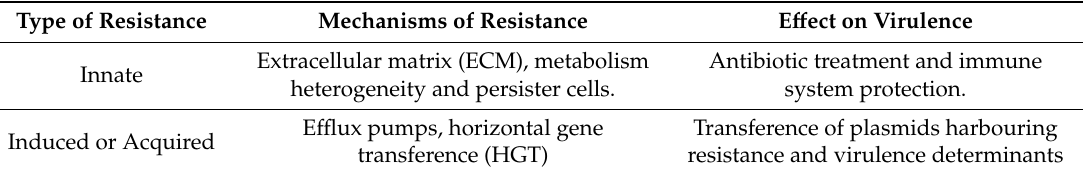
Table 4. Relationship between virulence and resistance among biofilms. Type of Resistance Extracellular matrix (ECM), metabolism Innate heterogeneity and persister